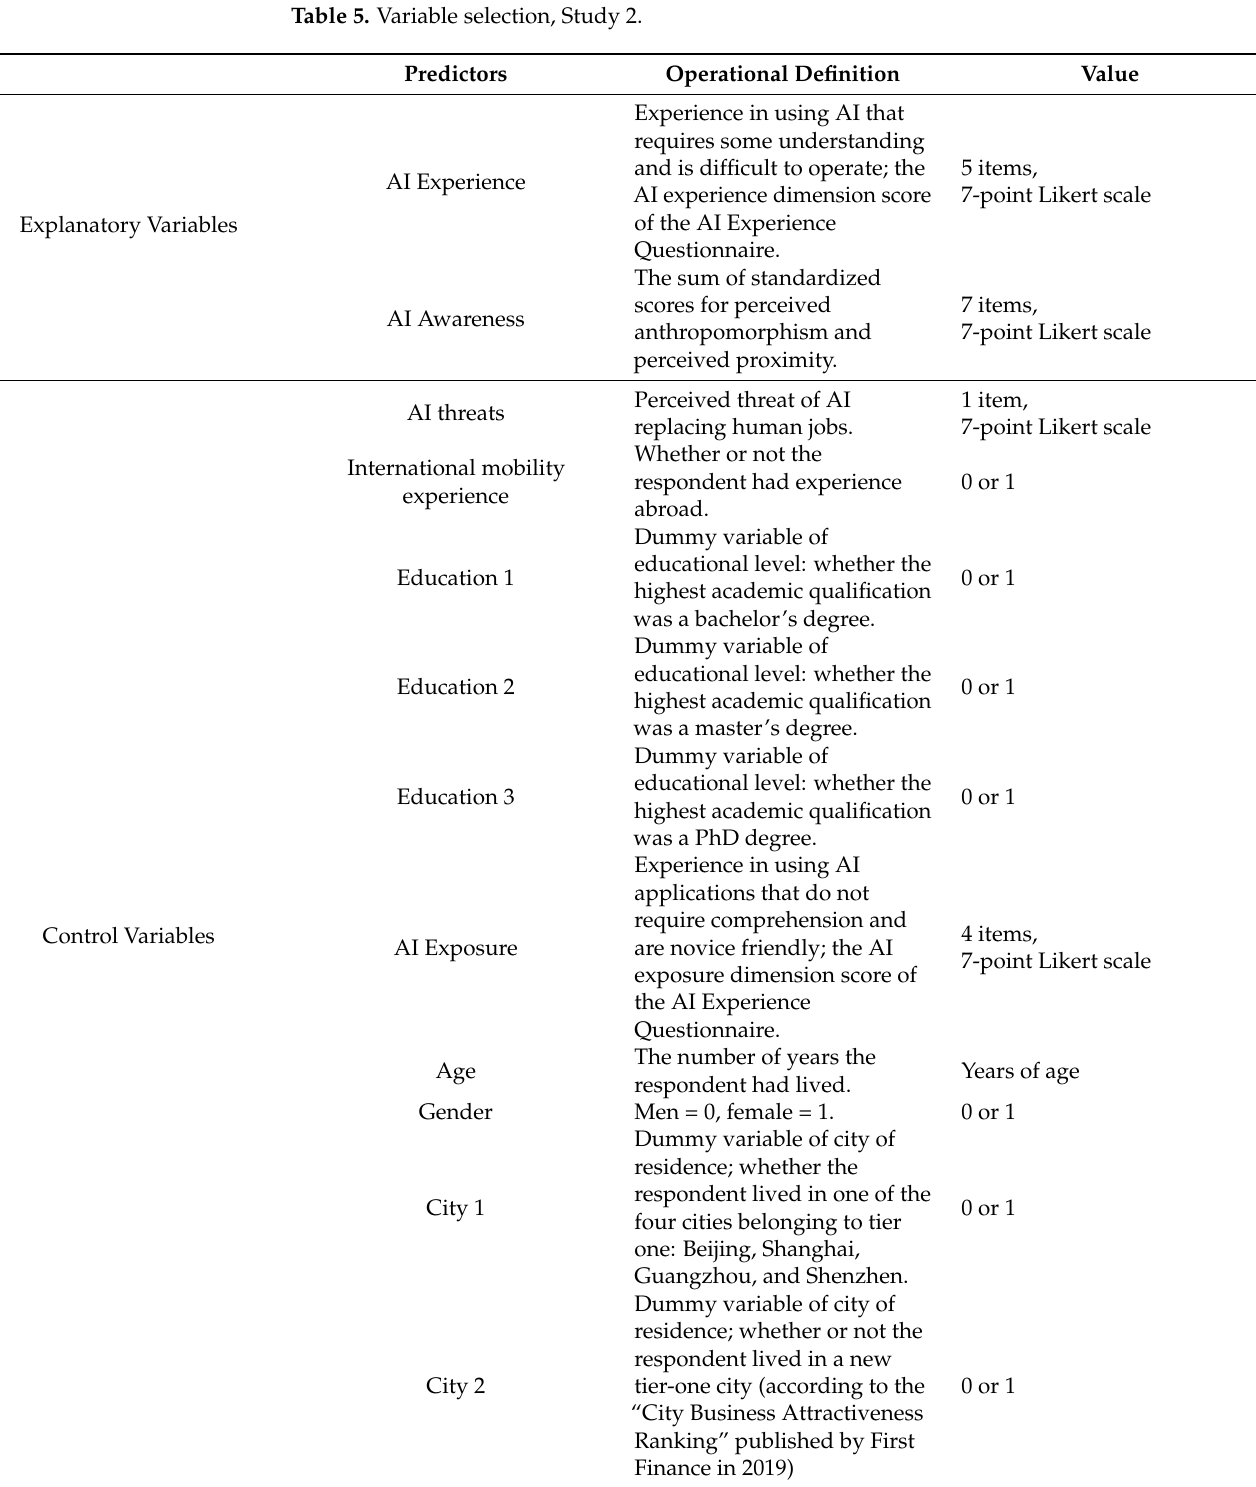
Table 5. Variable selection, Study